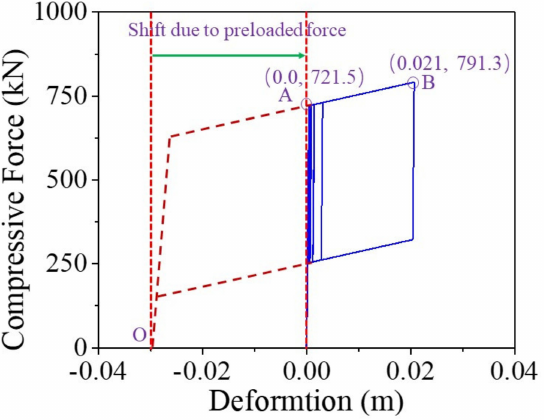
Figure 18. Compressive force vs. deformation of SMA washer set. The maximum and average maximum seismic responses regarding the aforemen- tioned damage indicators of the conventional and the resilient bridges with the ECC-reinforced piers under E1 and E2 level earthquakes are summarized in Tables 3 and 4,